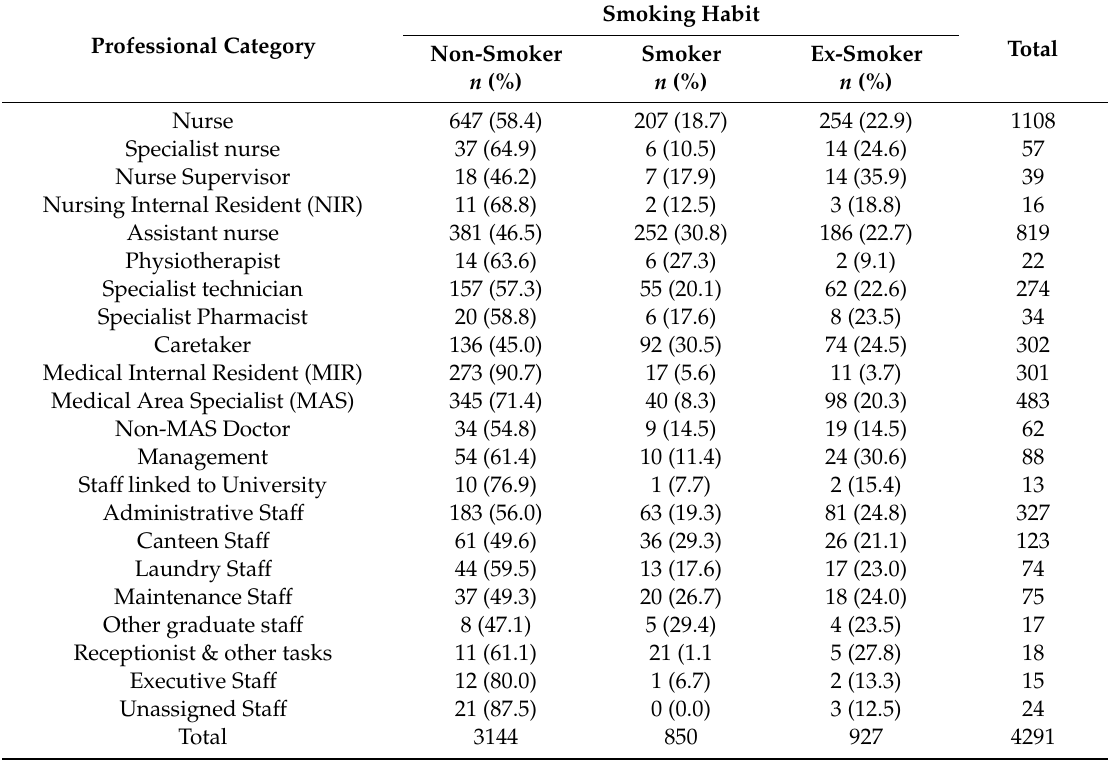
Table 4. Smoking habit according to professional category of the hospital sta ff evaluated.